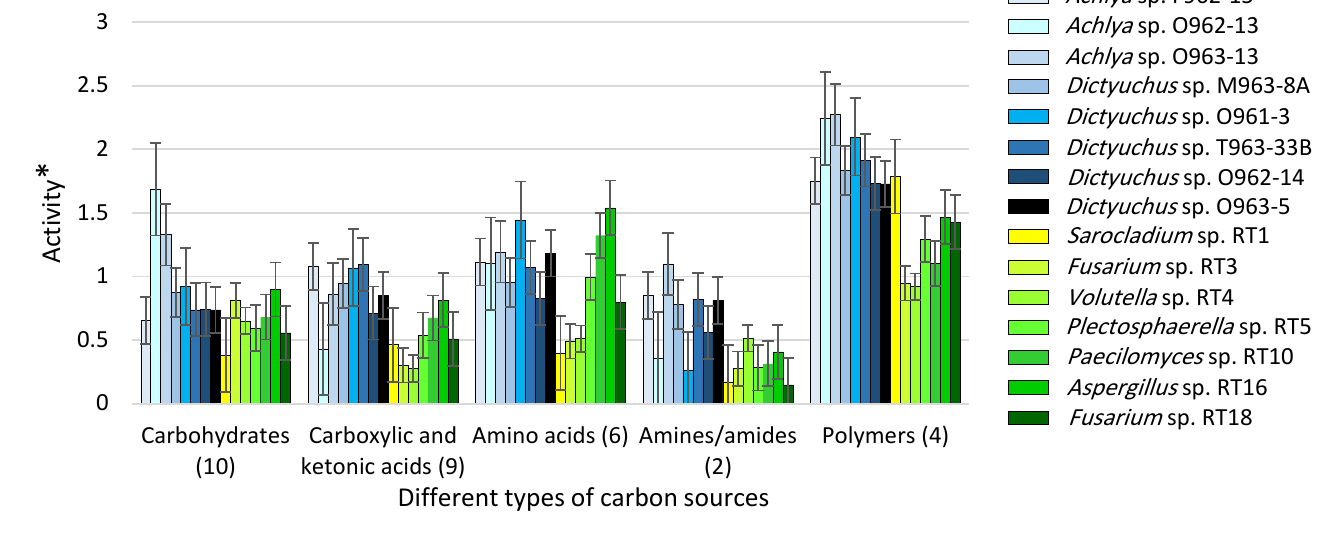
Figure 4. The activity of fungal and Saprolegniales strains inoculated to the EcoPlate™ plates after 216 h (see Figure S2 for more details about the specific carbon sources) (* = Optical density (OD) of carbon source wells inoculated with strains—OD of the control well at 590